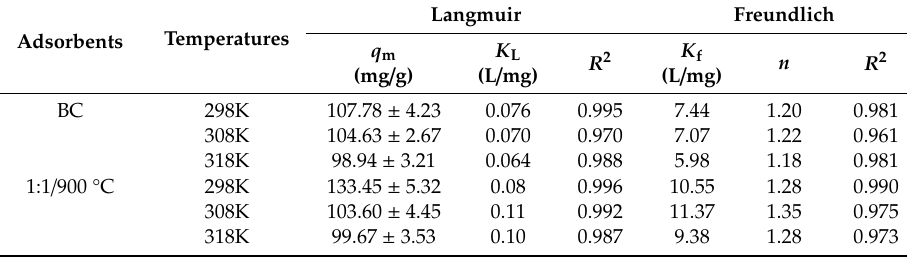
Table 4. Isotherm models parameters for E2 adsorption by BC and 1:1 / 900 ◦ C.